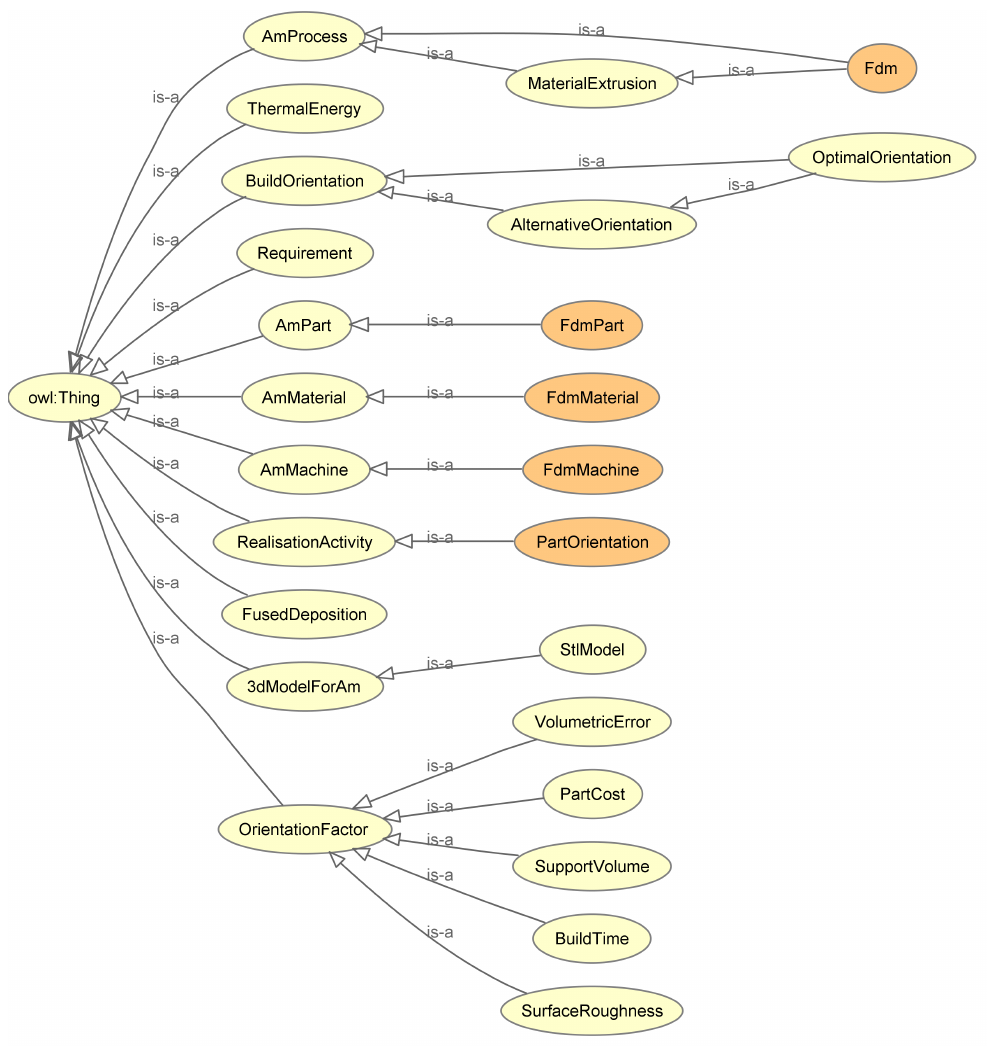
Figure 3. Graphical representation of twenty-five top-level concepts in the DL